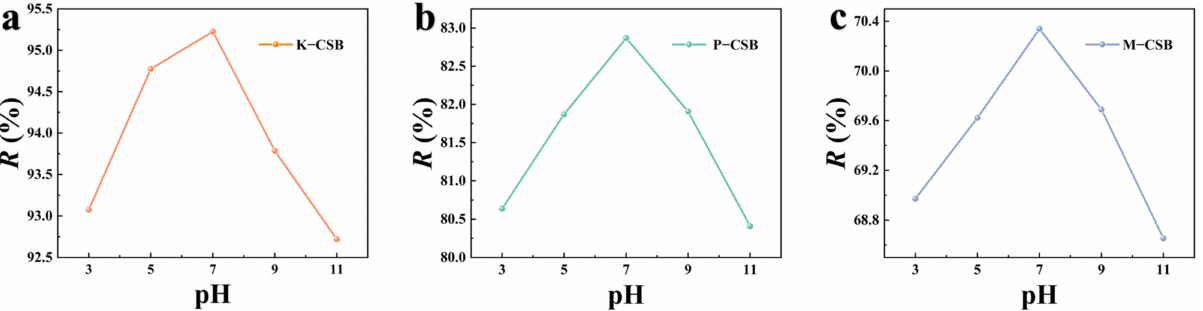
Figure 7. The effect of initial pH on TC adsorption by modified carb shell biochar (( a ) is K − CSB, ( b ) is P − CSB, and ( c ) is M −